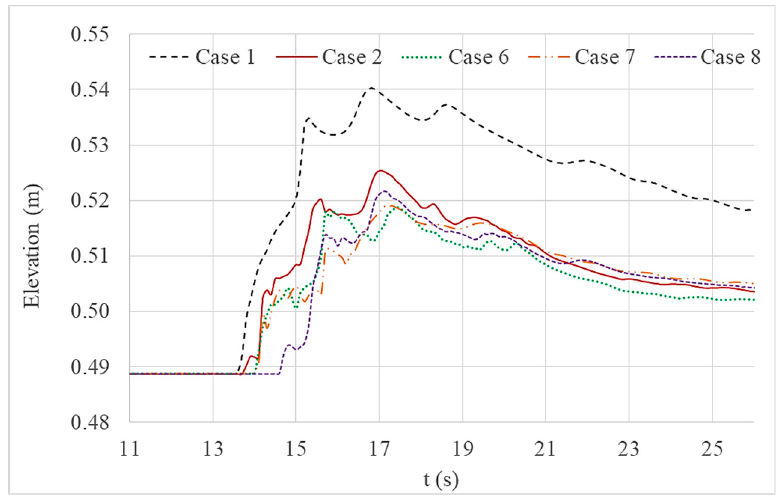
Figure 11. Comparison of water level variations at location D.